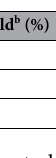
Table 4. Recyclability study of CP1